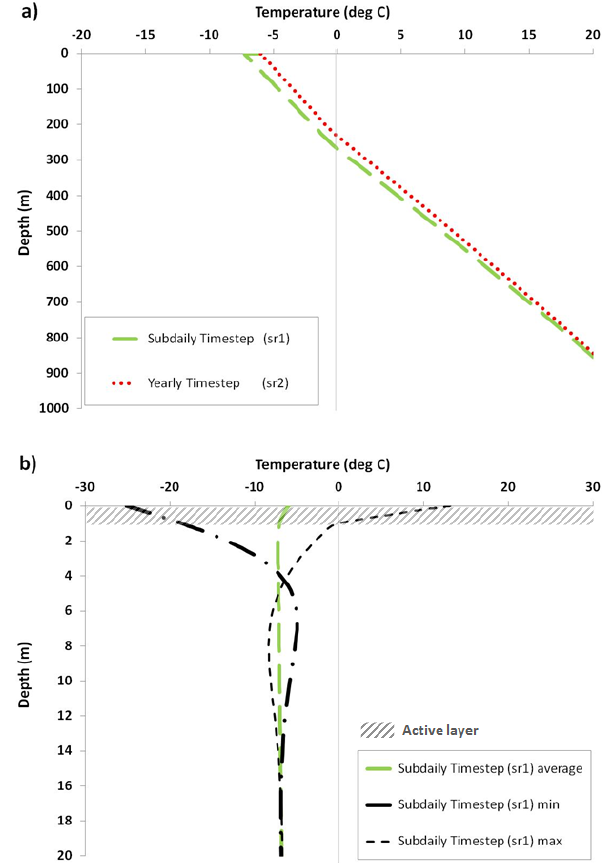
Figure 1. (a) Plot comparing VAMPER model results using differ- ent time steps (annual vs. sub-daily) but the same annual average temperature forcing of − 6 ◦ C. (b) Plot showing the sr1 average, minimum and maximum temperature–depth profiles. Also shown in (b) is the ∼ 1m active layer, marked as diagonal